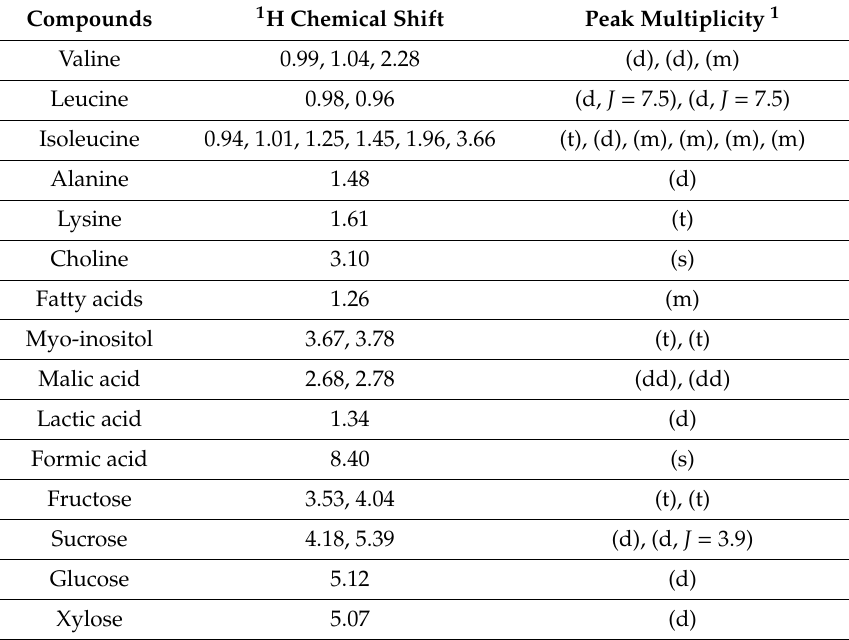
Table 3. Characteristic 1 H-NMR peaks of apricot byproduct extracts identified in the principal component analysis (PCA)